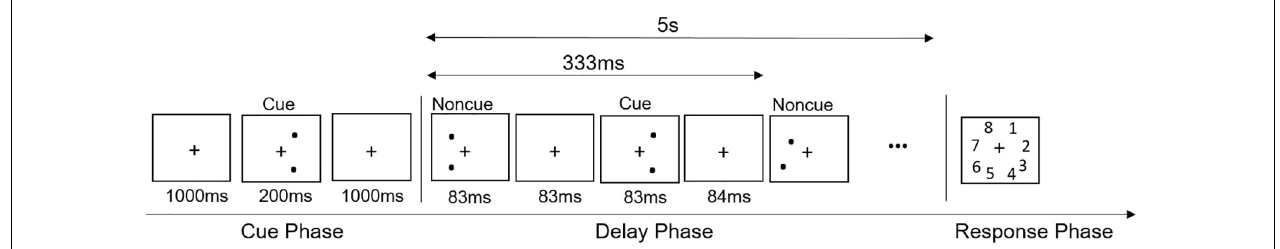
FIGURE 2 | The task outline of the steady-state visual evoked potentials for working memory (SSVEP-vsWM).